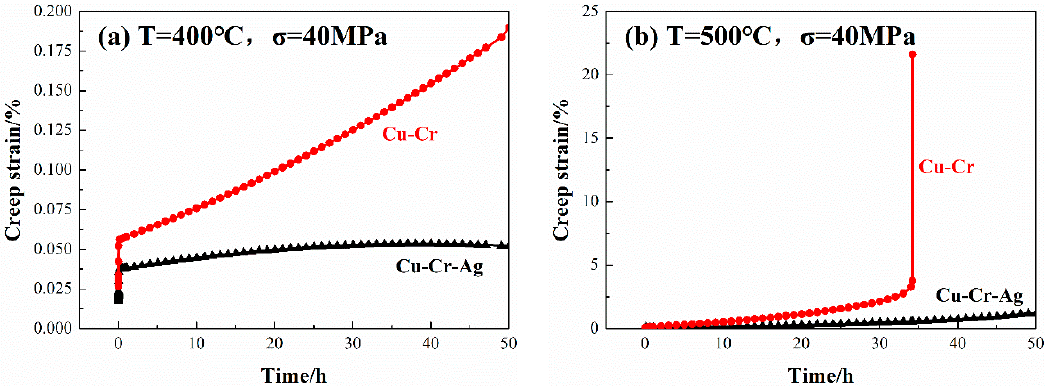
Figure 3. Creep curves of alloys at ( a ) 400 and ( b ) 500 °C under 40 MPa stress.